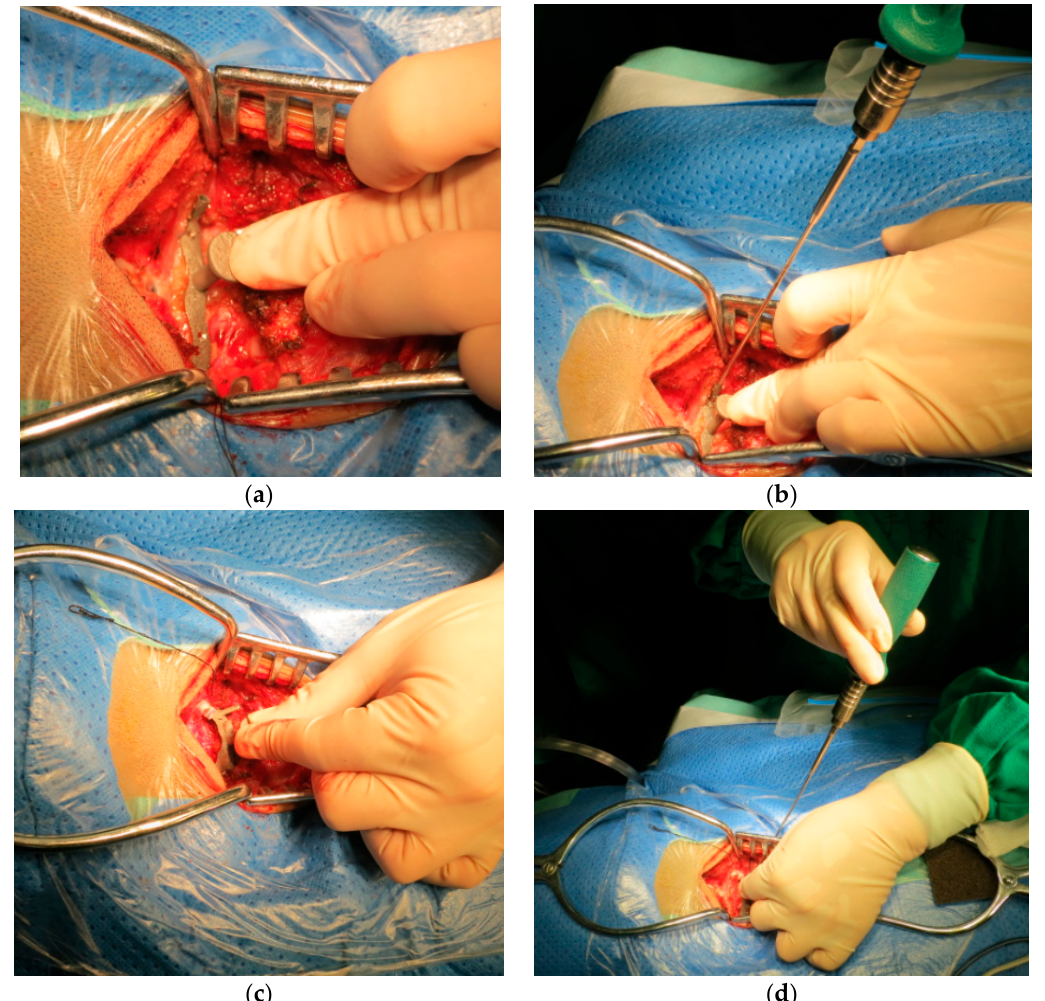
Figure 10. ( a ) Use of the atlas template; ( b ) insertion of screws into atlas using the template; ( c ) use of the axis template; ( d ) insertion of screws into the axis during the operation involving the insertion of high-precision screws with templates.